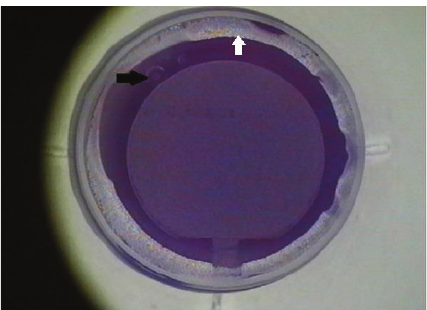
Figure 1: Anterior chamber gas bubble formation during femtosec- ond laser flap creation for LASIK. Femtosecond laser scout view of the cornea immediately after the femtosecond laser treatment. Note the small anterior chamber bubbles in the upper left-hand corner of the image (black arrow) as well as the 360-degree ring of opaque bubble layer that dissected toward the peripheral cornea until termination at Schwalbe’s line (white